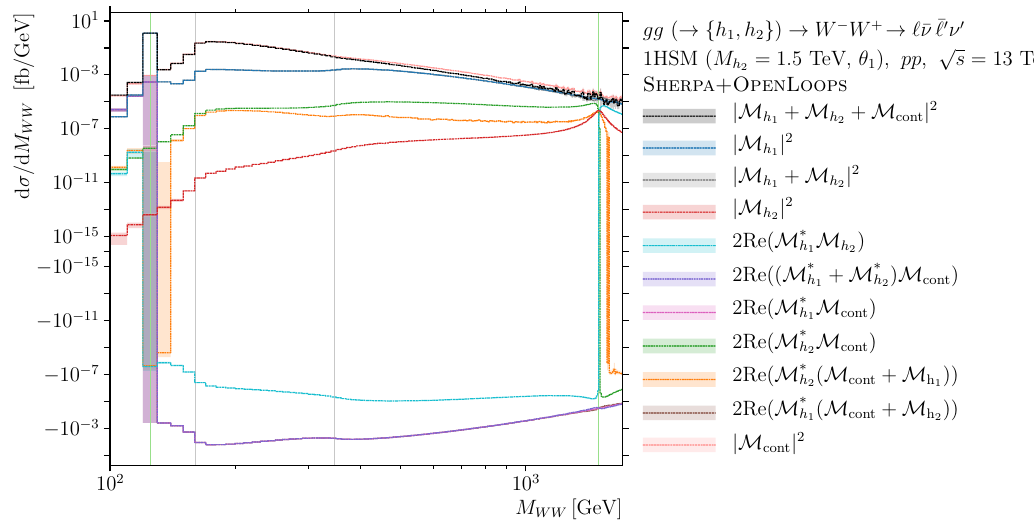
+ Figure 4 . M (cid:26) ¯ ν ¯ (cid:26) (cid:30) ν (cid:30) in WW distributions for the signal process gg ( → { h 1 , h 2 } ) → W − W → = 1500 GeV and mixing angle θ 1 (see the 1-Higgs-Singlet Extension of the SM (1HSM) with M h 2 table 1) including its interference with the background in pp collisions at √ s = 13 TeV. Vertical lines indicate the position of the WW and t ¯ t thresholds (grey) and of the Higgs resonances (green). The selection cuts in (4.1) are applied. Cross sections are given for a single lepton flavour combination. The bands show the MC integration error estimate (90% confidence interval).